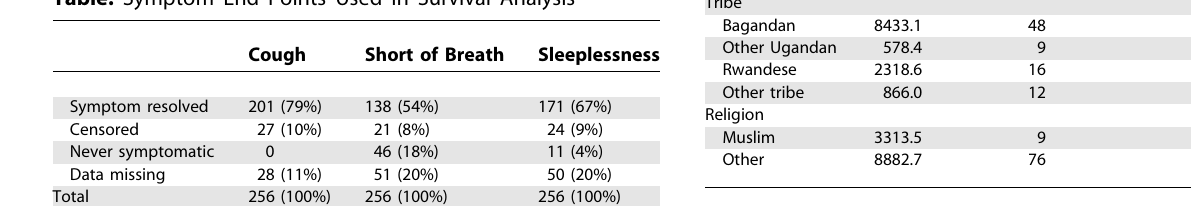
Table. Symptom End Points Used in Survival Analysis